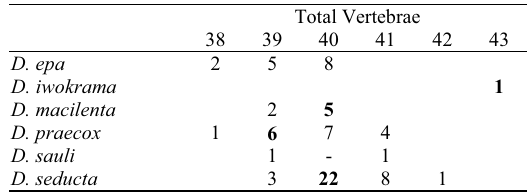
Orinoco basin, those localities are not plotted on Fig. 46.